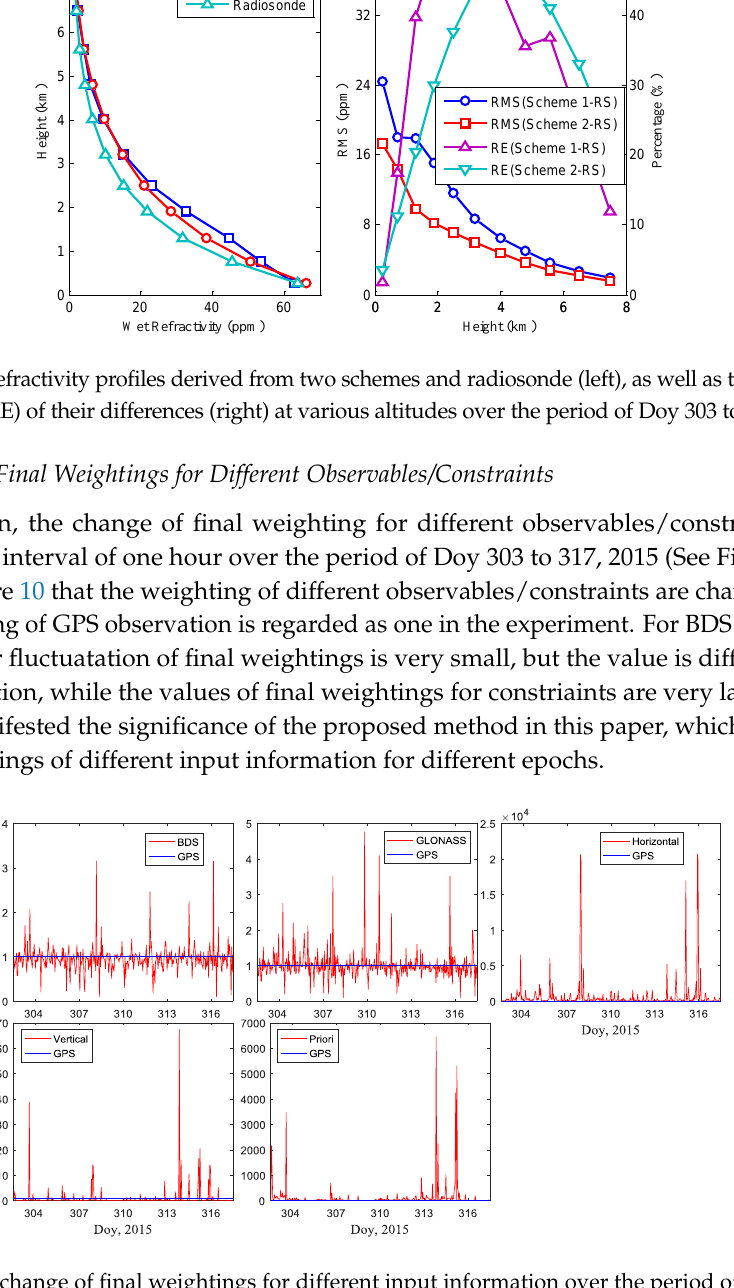
Figure 10. The change of final weightings for different input information over the period of Doy 303 to 317, 2015, while the weight of GPS observation is regarded as one.